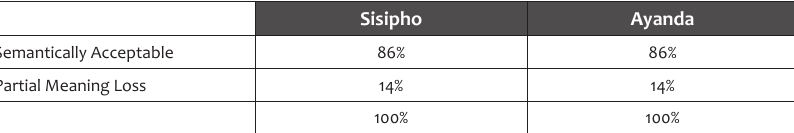
Table 4: Adult Readers: ‘Retained meaning’ and ‘Partial meaning loss’ Miscues Sisipho Ayanda